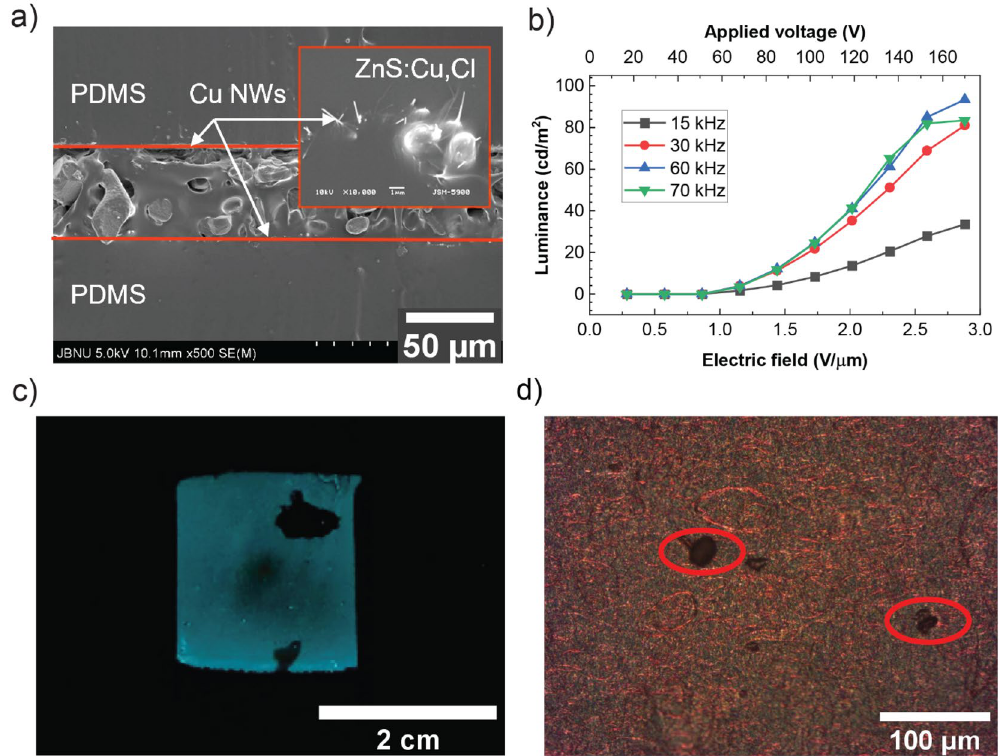
Figure 5. ( a ) Cross-sectional SEM image of the fabricated ACEL device with the weight ratio of ZnS:Cu/ PDMS = 3:1; magnified image is presented in the inset. ( b ) Luminance measured with increasing bias voltage under various frequency. ( c ) Optical image of the emitting sample at 4 V/ µ m of electric field. ( d ) Microscopy image (top view) of the emitting sample at 4 V/μm of electric field.